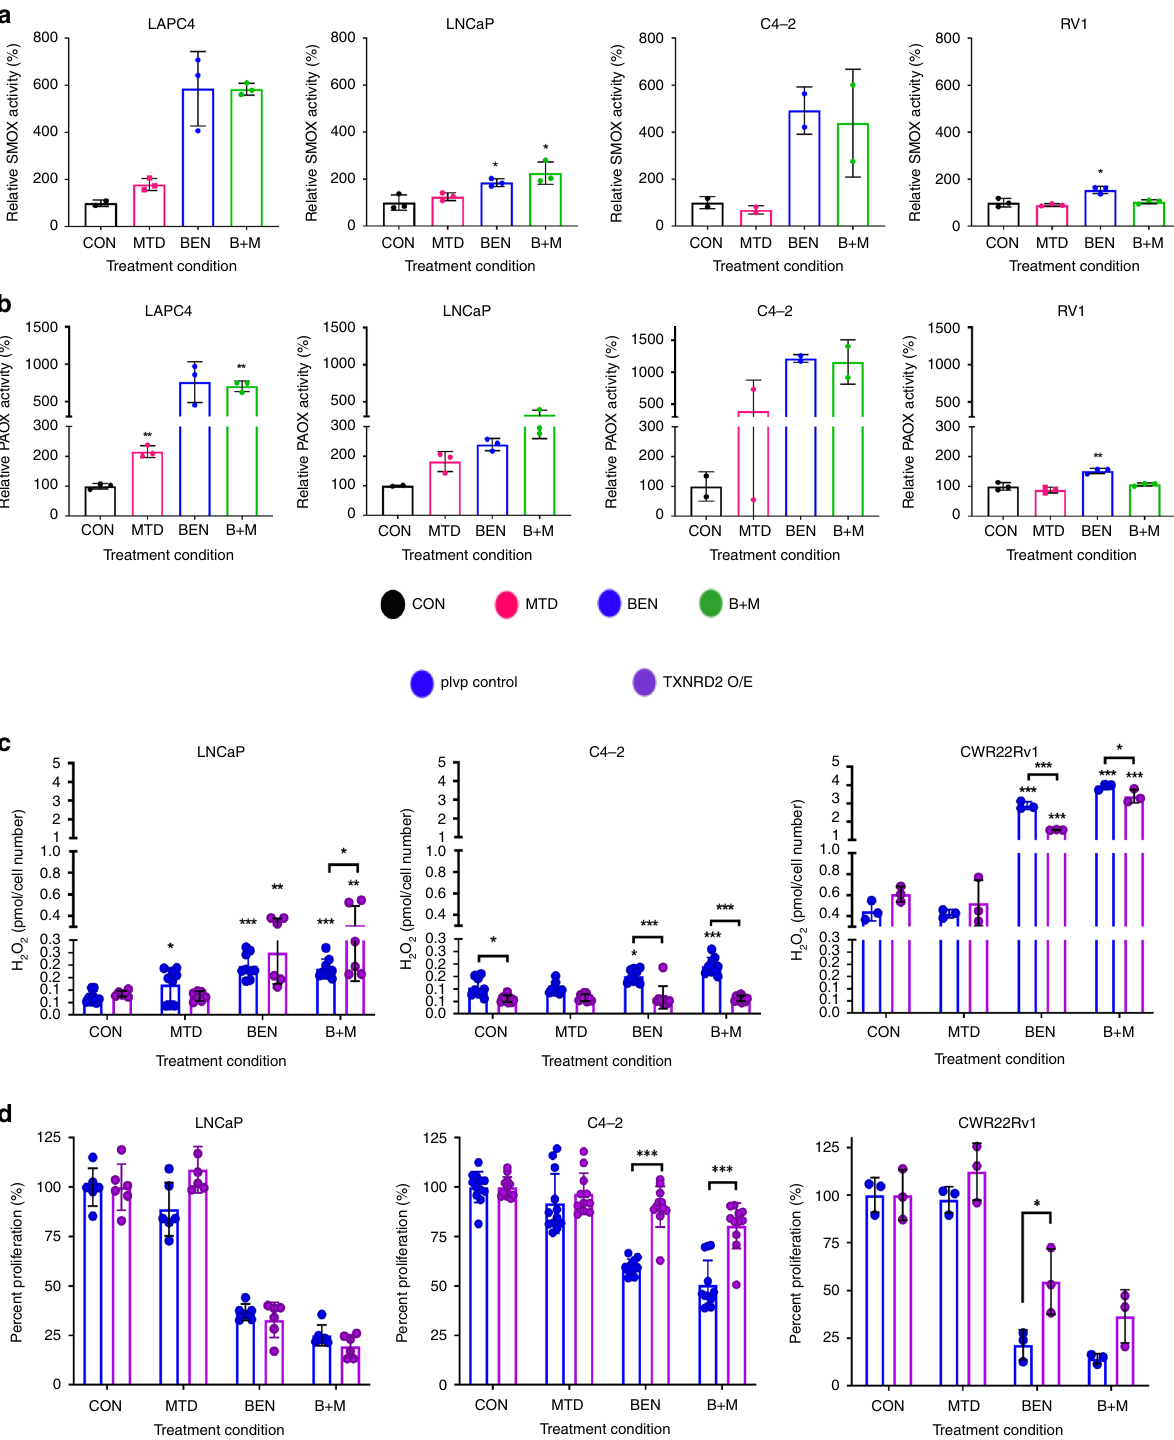
Fig. 4 BENSpm and the combination enhance polyamine catabolism and reactive oxygen species production. Cells were treated with vehicle control (black bars), 1 nM MTDIA (red bars), 1 µ M BENSpm (blue bars) or the combination (B + M) (green bars) for 8 days in the presence of 20 µ M MTA. a SMOX and b PAOX enzyme activity. Values are indicative of the amount of H 2 O 2 produced normalized to protein concentration, relative to vehicle controls. Statistical analyses were performed using an unpaired Student ’ s t -test with Welch ’ s correction. c The amount of reactive oxygen species (ROS) produced normalized to cell number in cells containing vector control (PLVP) (blue bars) or thioredoxin reductase 2 ( TXNRD2 ) overexpression (O/E) (purple bars) for LNCaP, C4-2, and CWR22Rv1 cells. d Percent cell proliferation (relative to vehicle control for each condition - PLVP or TXNRD2 O/E) for LNCaP, C4-2, and CWR22Rv1. Results for biological triplicates are shown. Statistical analyses were performed using an unpaired Student ’ s t -test with Welch ’ s correction. All values are compared to vehicle control unless otherwise indicated by connecting lines. Error bars represent standard error of the mean. * p < 0.05, ** p < 0.01, *** p <